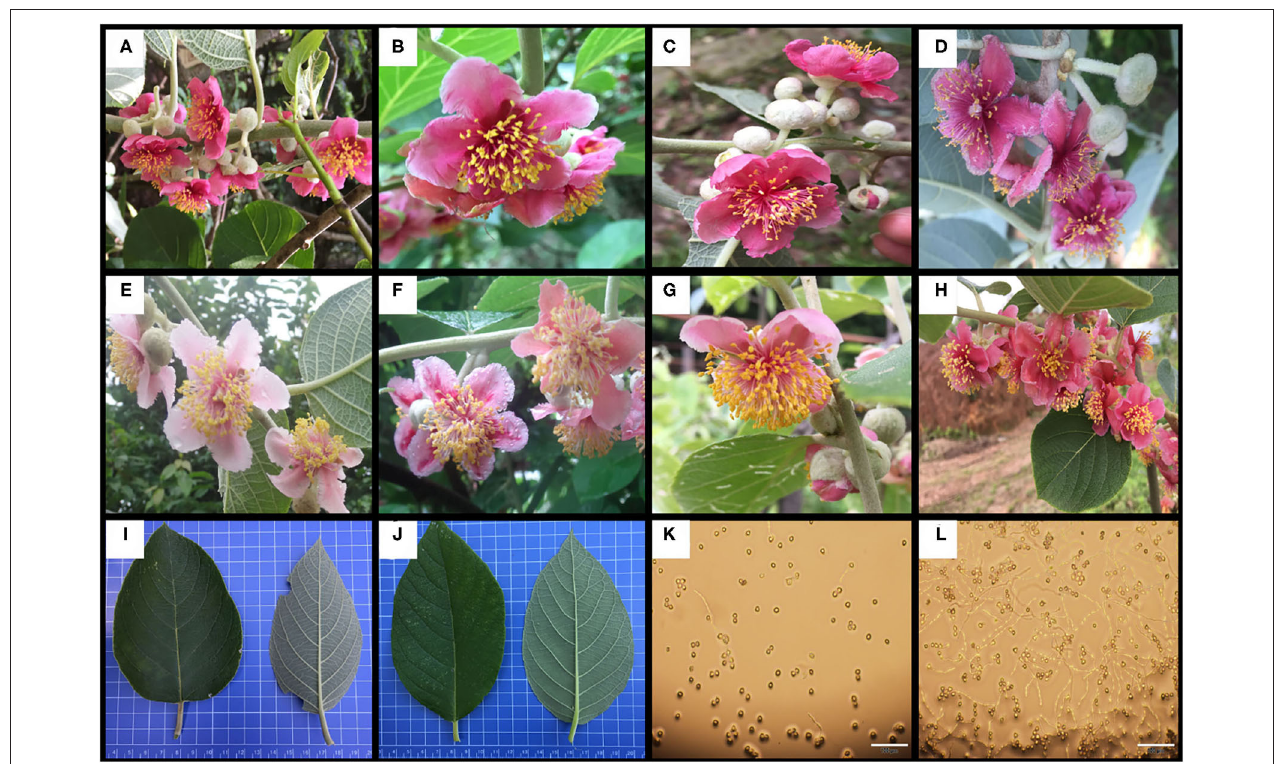
FIGURE 1 | Some germplasm with specific traits. (A–D) the petals have higher anthocyanin content; (E–H) the flower contains more stamens; (I, J) different leaf shapes, the indicators on the leaf are mainly some quality indicators; (K) low pollen viability type; (L) high pollen viability type.